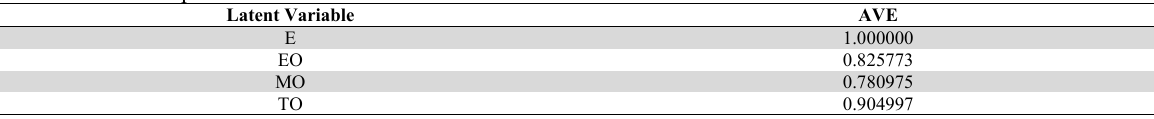
Latent Variable